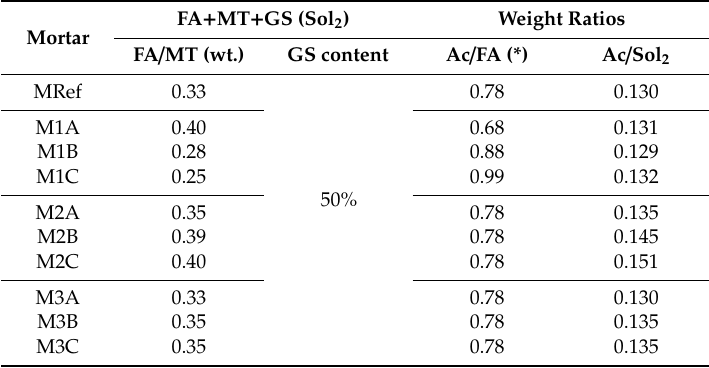
Table 3. Identification and nominal characterization of the mortars (FA = fly ash; MT = mine tailings; GS = soil; Ac =